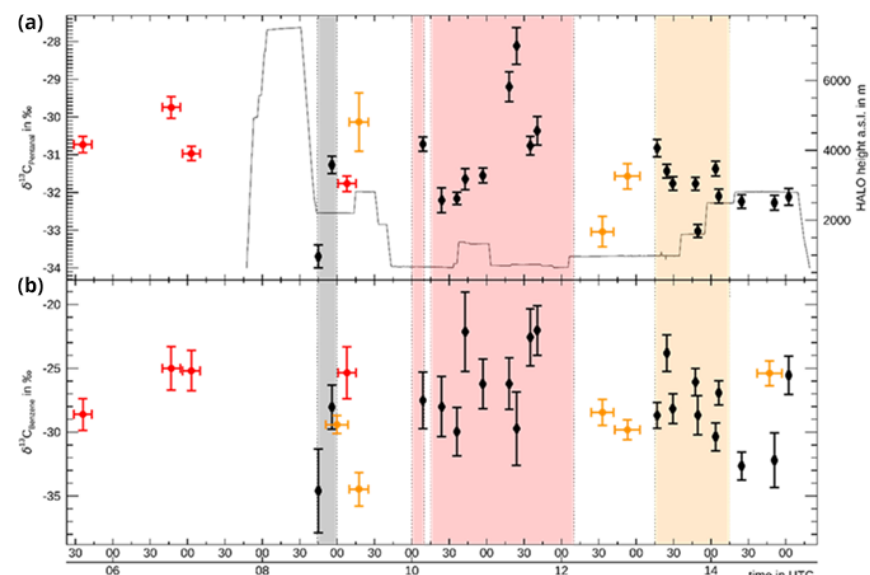
Figure 36. δ 13 C values in C 5 H 10 O (a) and C 6 H 6 (b) in whole air samples gathered with the whole air sampler MIRAH on the HALO aircraft (black) during E-EU-08 as well as on the ground sites in London (red) and Wuppertal (orange). The HALO flight altitude is given in grey on the top panel. Background shadings indicate different measurement regions during the flight according to Fig. 4: Paris (grey), south of London and North Sea region (red), and BNL/Ruhr (orange).